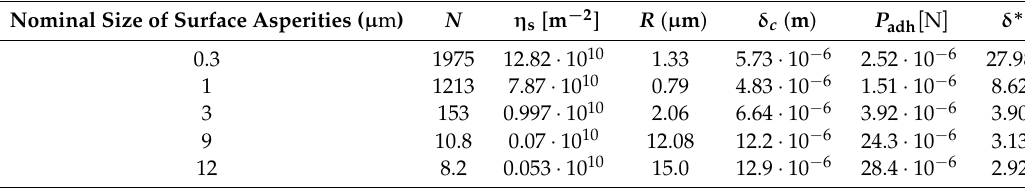
Table 3. The parameters of the Galanov